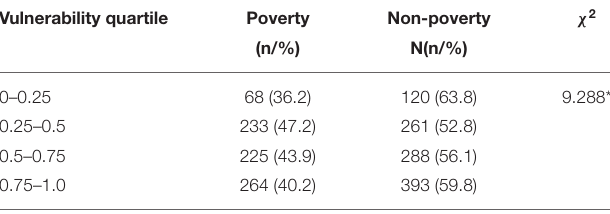
TABLE 2 | People with low vulnerabilities had a high incidence of poverty. Vulnerability quartile